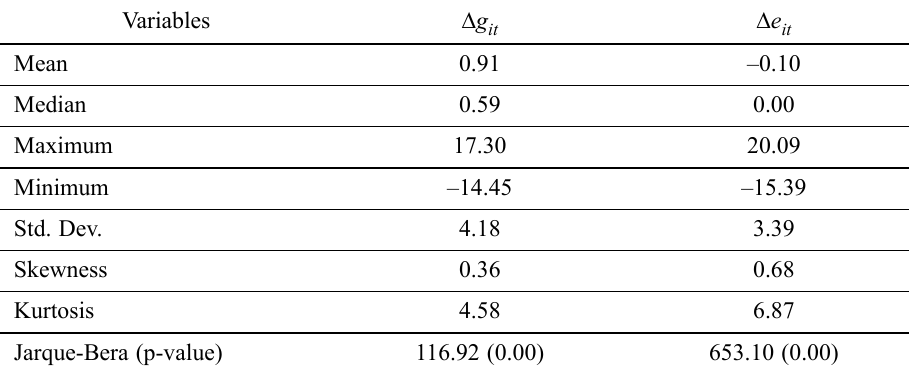
Table 1. Summary of basic